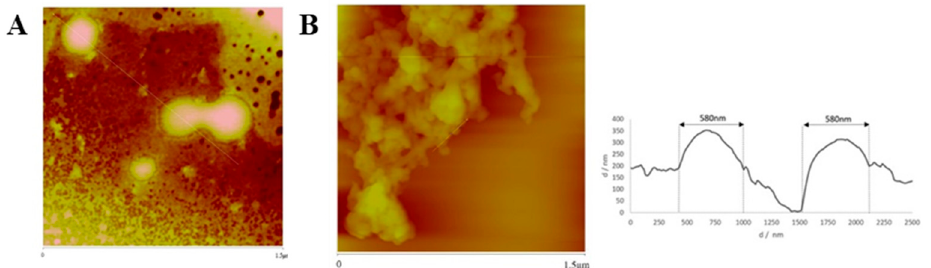
Figure 7. AFM images (2D and sectorial images) with size scale of ( A ) PvD-loaded, and ( B ) Empty ERL-CET conjugated NPs.